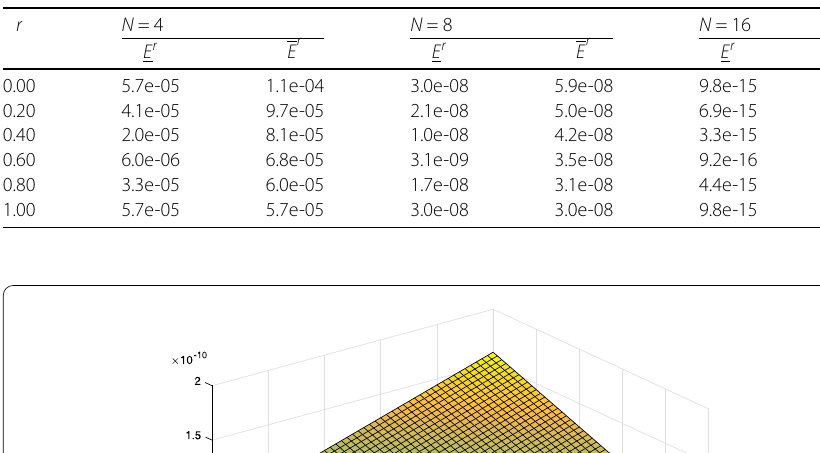
Table 5 Numerical errors on the level sets with N = M in ( x , y ) = (0.5.0.5) for Example 5.3